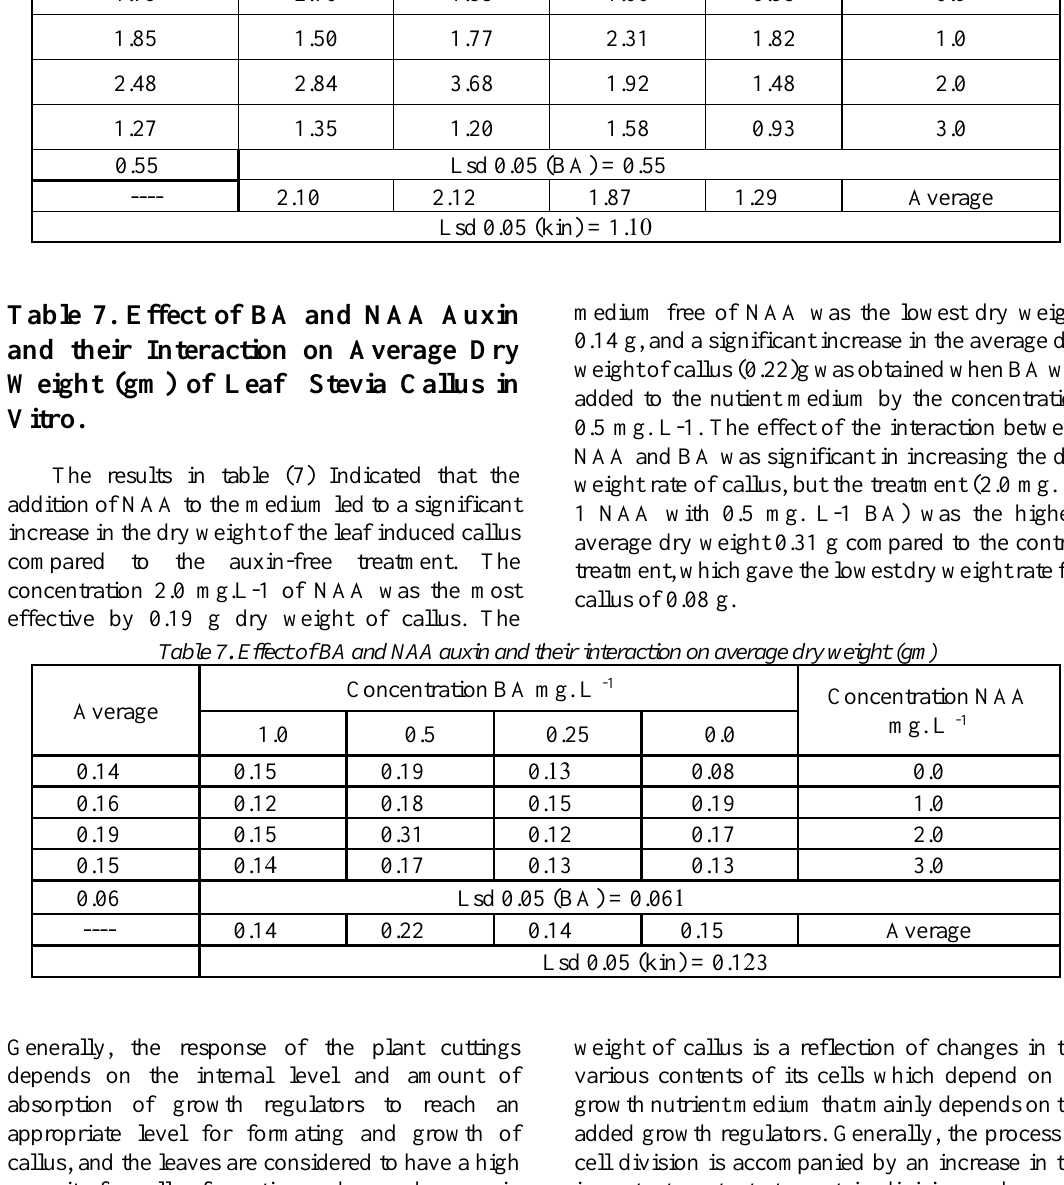
Table 6.Effect of BA and NAA auxin and their interaction on average wet weight (gm) of leaf stevia callus in vitro